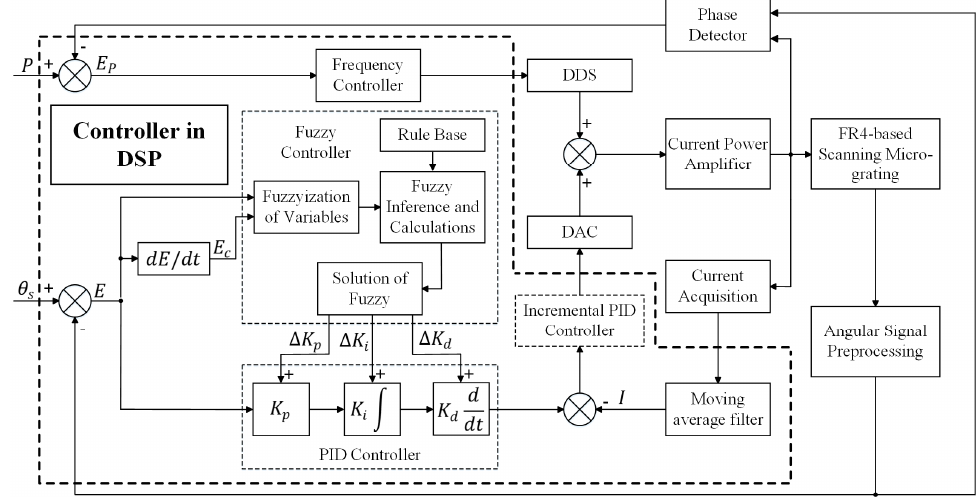
Figure 6. Block diagram of the compound control algorithm.